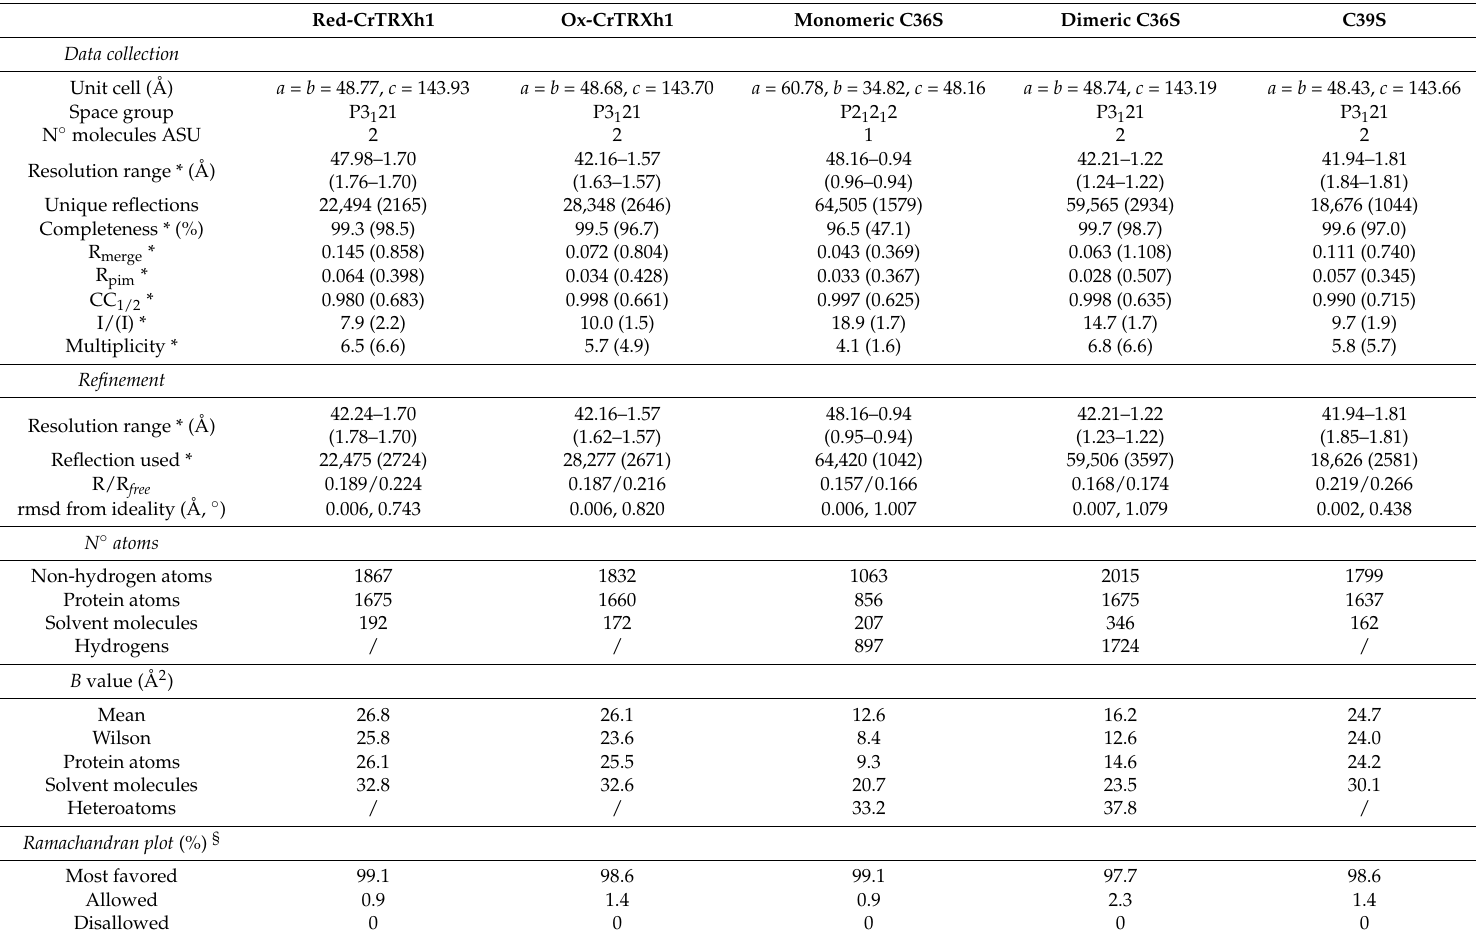
Table 1. X-ray data collection and refinement